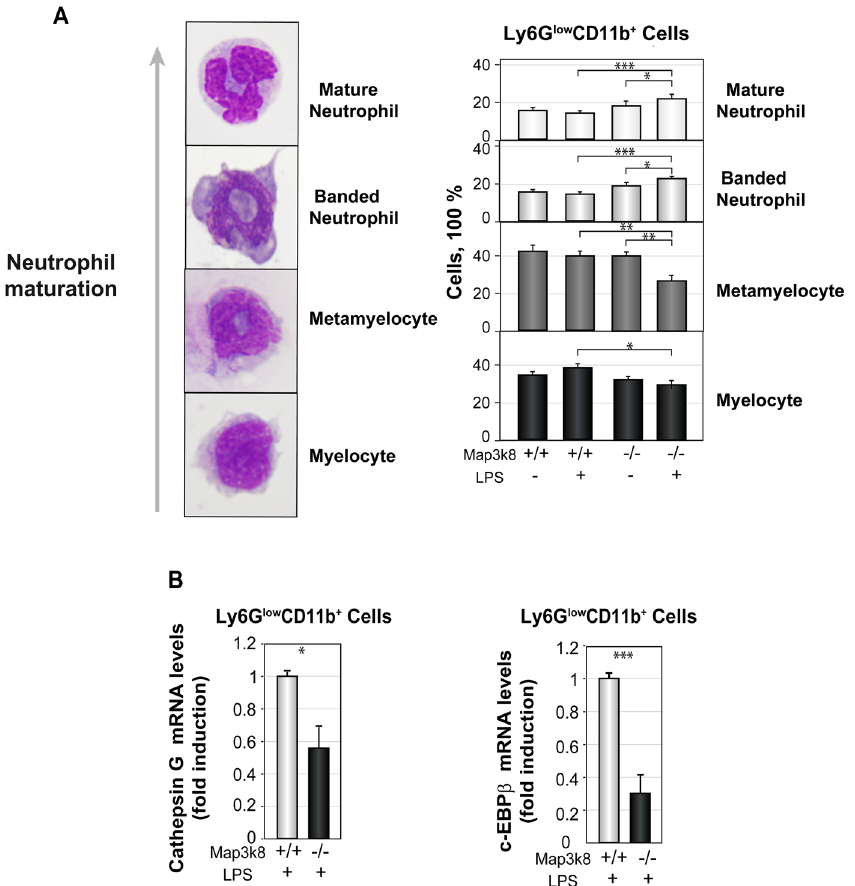
Figure 4. Analysis of BM Ly6G low CD11b + immature neutrophils from LPS-treated Wt and Map3k8 − / − mice. ( A ) Representative images of cells at different stages of neutrophil maturation are shown at the left. Sorted BM Ly6G low CD11b + immature neutrophils from non-treated and LPS-treated Wt and Map3k8 − / − mice were subjected to cytospin centrifugation and Wright-Giemsa staining. The percentages of the various neutrophil precursors in the cell populations were scored by two different researchers who were blinded to the groups. The proportions of myelocytes, metamyelocytes, and banded and mature neutrophils within the sorted BM Ly6G low CD11b + neutrophil population are shown. Data are presented as the mean ± SEM from three different experiments performed in triplicate. Newman-Keuls tests were used to compare groups. ( B ) Cathepsin G and C/EBP β mRNA levels in the sorted Ly6G low CD11b + immature neutrophils from BM of LPS-treated mice were determined by RT-qPCR. Expression was analysed after normalization to S18. The graphs show the mean ± SEM of three different experiments, each conducted on a pool of cells from three animals. Two-tailed Student’s t -tests were used for comparisons of two groups. ( A , B ) * p < 0.05, ** p < 0.01, *** p <